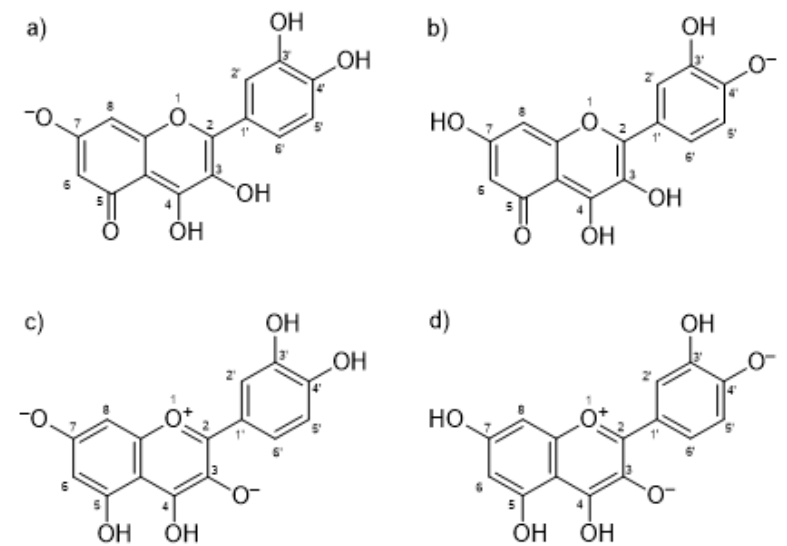
Figure 3. Docked quercetin species: ( a ) anion at Position 7; ( b ) anion at Position 4 ′ ; ( c ) fluorescent dianion at Positions 3 and 7; and ( d ) fluorescent dianion at Positions 3 and 4′ .